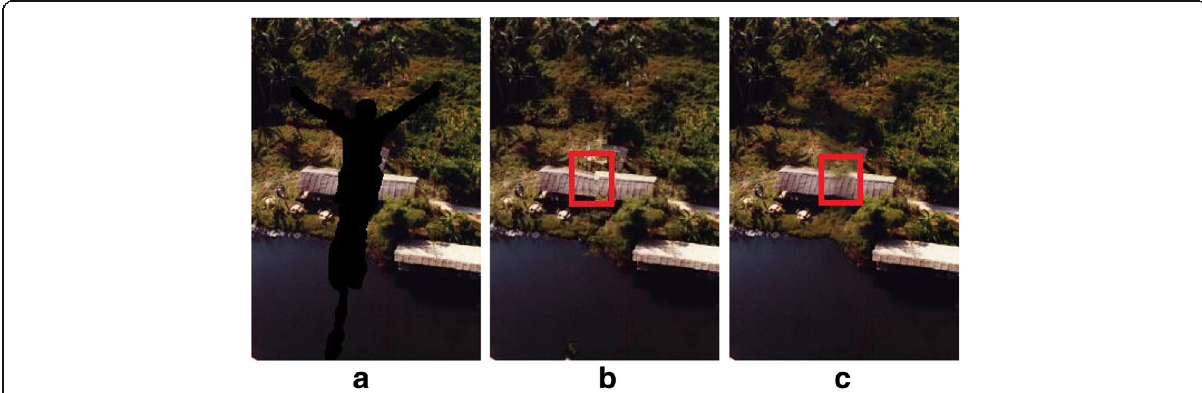
Fig. 11 A comparison of inpainted results using fixed patch and dynamic patch. a Mask. b A fixed patch. c Dynamic patches